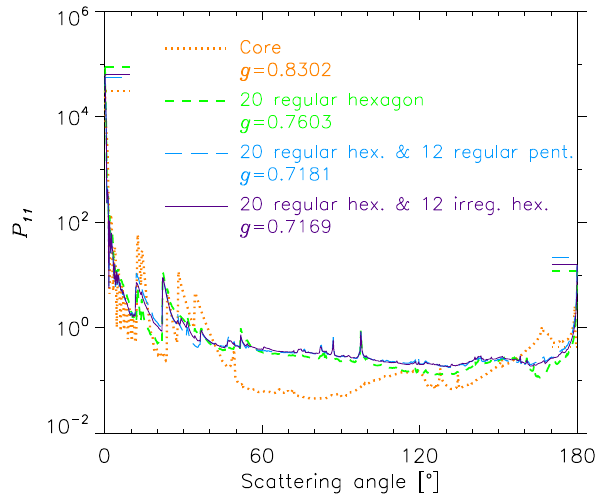
Fig. 10. P 11 and g for the 3B core (yellow), 3B with 20 regular hexagonal columns (green), 3B with 20 regular and 12 regular pentagonal columns (blue), and 3B with 20 regular hexagonal and 12 irregular hexagonal columns (purple). The direct forward and backward peaks are indicated by bars. The shape of each 3B is shown in Fig. 7.